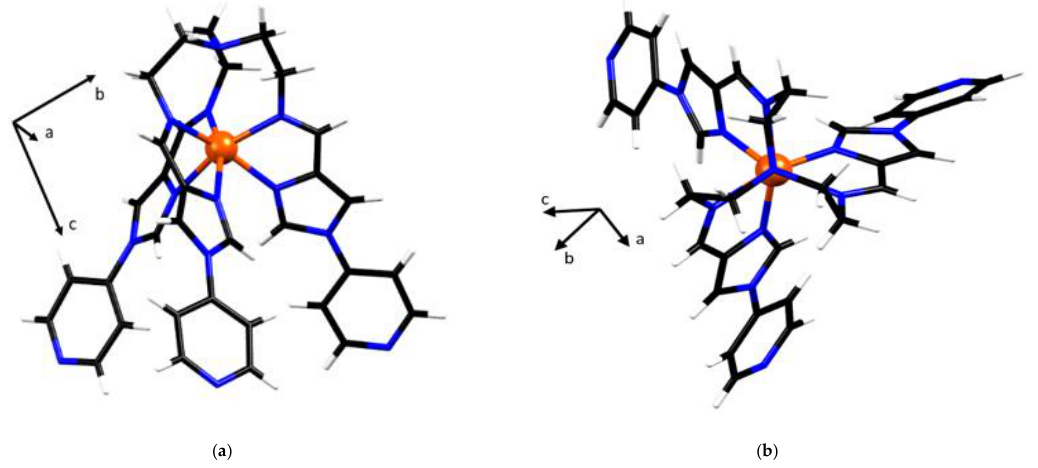
Figure 2. Crystal structure of the metalloligand FeL 2+ . Colour codes: Fe, orange; C, black; N, blue; H, white. Solvent and anions are not shown. ( a ) Single crystal structure of (lambda) metalloligand FeL 2+ . (side view), and ( b ) metalloligand FeL 2+ . Viewed down the C 3 axis. The cell direction vectors are to scale with the cell parameters in each